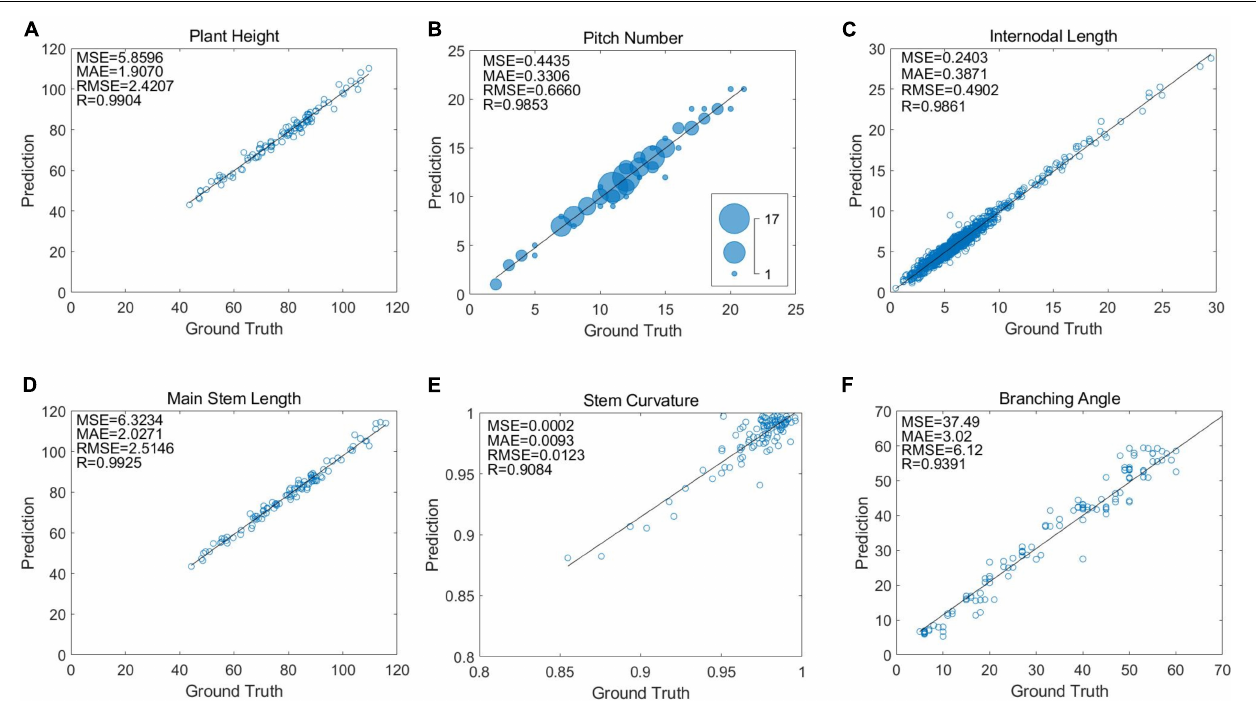
FIGURE 10 | Correlation analysis between true value and predicted value of soybean plant phenotypic information: (A) the correlation analysis diagram between the true value and the predicted value of plant height, (B) the correlation analysis diagram between the true value and the predicted value of pitch number, (C) the correlation analysis diagram between the true value and the predicted value of internodal length, (D) the correlation analysis diagram between the true value and the predicted value of main stem length, (E) the correlation analysis diagram between the true value and the predicted value of stem curvature, and (F) the correlation analysis diagram between the true value and the predicted value of branching